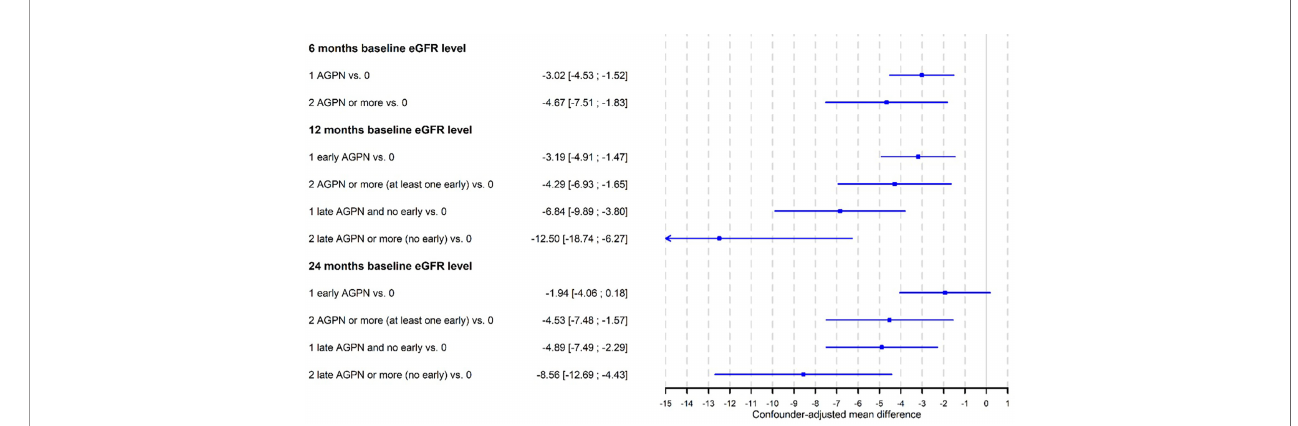
FIGURE 2 | Confounder-adjusted mean differences of eGFR at baseline according to the number of acute graft pyelonephritis (AGPN) episodes estimated from multivariable